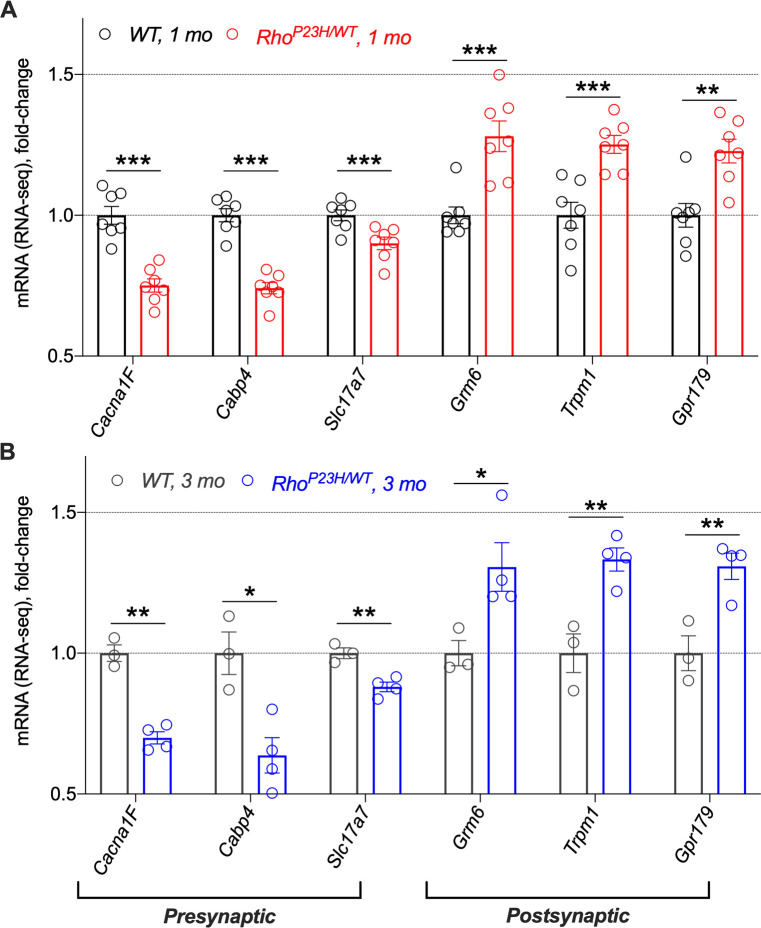
P23H retinas show opposing and persistent mRNA expression regulation in genes required for synaptic transmission in pre- versus postsynaptic sites.EData was obtained from 1-month-old (A) and 3-month-old (B) mice. Expression levels were obtained from FPKM reads. Data are normalized to WT values at 1.0. Note that the decreased mRNA expression of presynaptic genes is likely a consequence of photoreceptor loss in whole retina extracts. Cacna1F encodes Cav1.4 calcium channel, Cabp4 encodes calcium-binding protein that interacts with Cav1.4, and Slc17a7 encodes vesicular glutamate transporter vGlut1. Grm6 encodes metabotropic glutamate receptor 6 (mGluR6), Trpm1 encodes transient receptor potential cation channel subfamily M member 1, and Gpr179 encodes an orphan G protein-coupled receptor GPR179. mGluR6, TRPM1 and GPR179 are required for normal depolarization at ON bipolar cells. Multiple comparisons corrected t-tests: *p<0.05, **p<0.01, ***p<0.001.